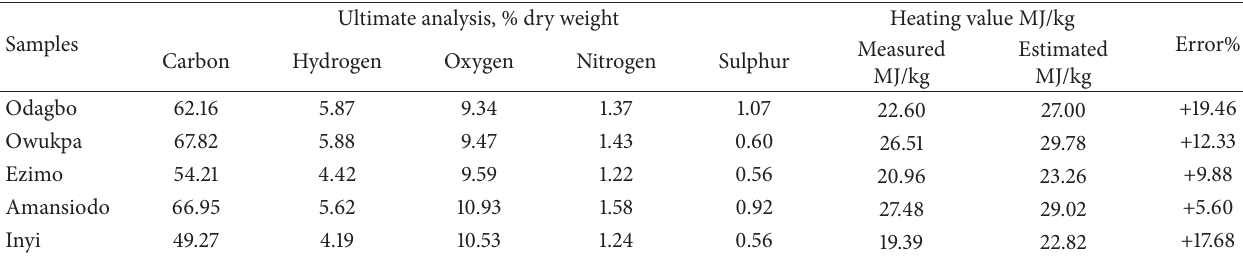
Table 3: Comparison of heating values of sample coals estimated from the Boie equation with measured values.